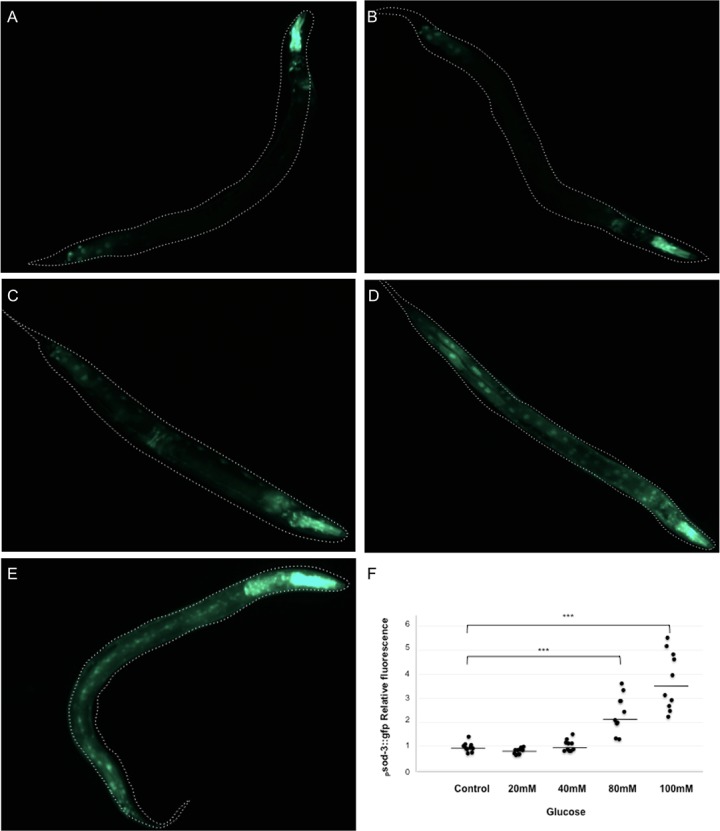
Psod-3::GFP expression after heat shock is higher when animals were grown in a HGD.(A-E) Psod-3::GFP transgen animals were exposed from L1 larvae to L4 larval stage to a diet of 0 (A), 20 (B), 40 (C), 80 (D) or 100 (E) mM glucose. To induce the expression of the reporter, animals were exposed to a heat shock of 31°C for 8 h. After heat shock, animals were mounted and observed for fluorescence. Representative pictures are shown for each case. The data of one of two independent replicates with similar results are shown. (F) Graph shows the relative expression level of each experimental condition. ***P < 0.001 (calculated using a one-way ANOVA test).